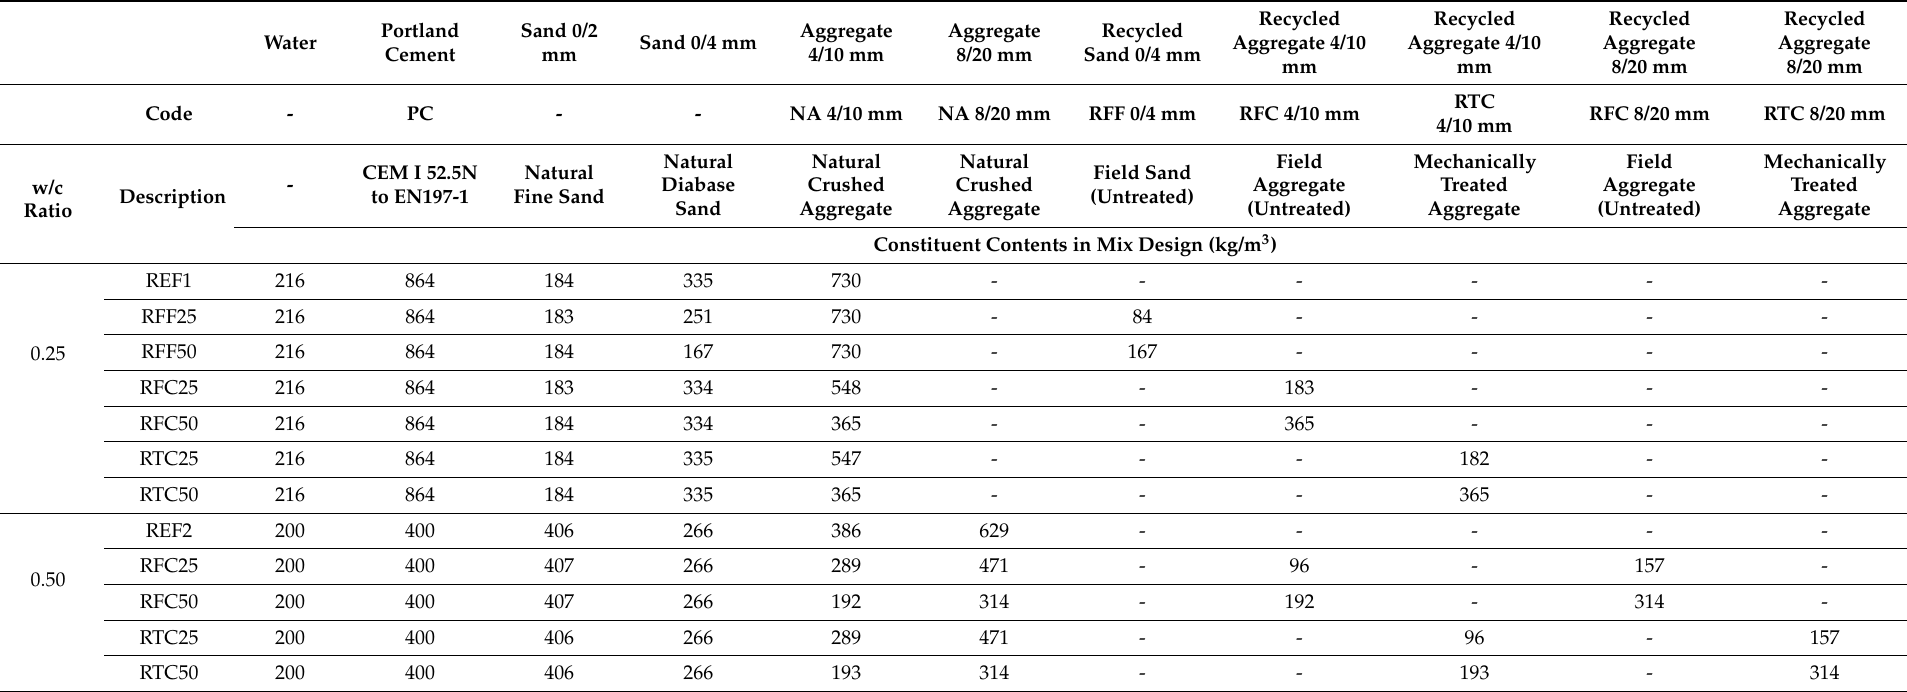
Table 3. Mix proportions, nomenclature, and replacement percentages of RCA in concrete